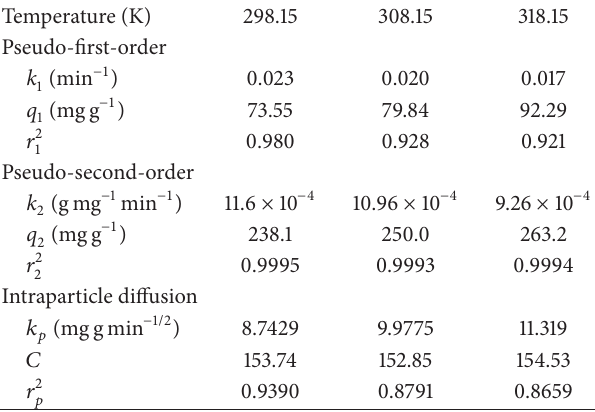
Table 1: Kinetic parameters for the adsorption of lead (II) ions onto the activated carbon